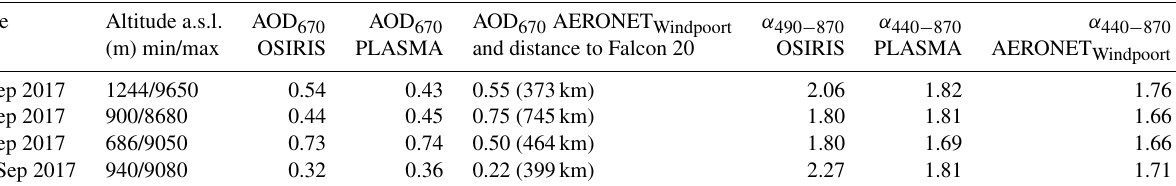
Table 1. Aerosol optical properties from AERONET, OSIRIS, and PLASMA2 measurements for four different descents in a loop during the AEROCLO-sA campaign.